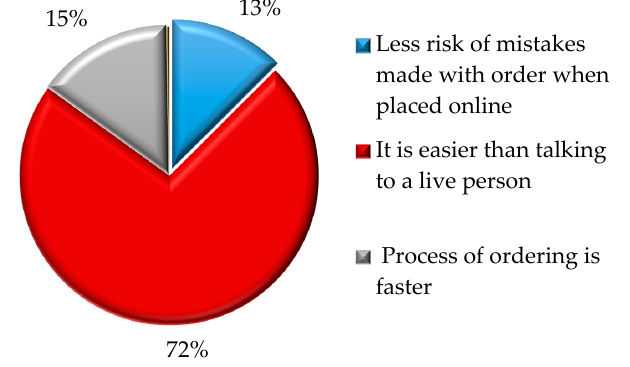
Figure 3. Factors that most influence the respondents to order food from an online web portal.